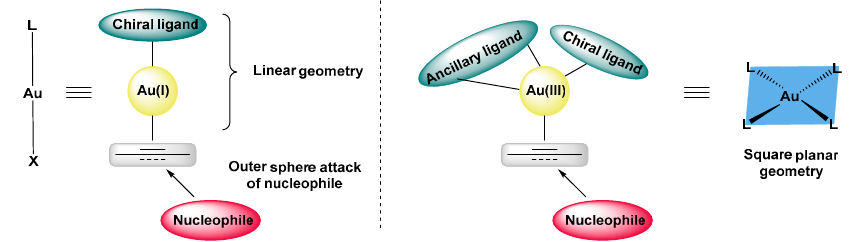
Figure 1. The geometry of gold(I) and gold(III) complexes, reproduced with the permission from Royal Chemical Society from ref. 17 (Figure 1).